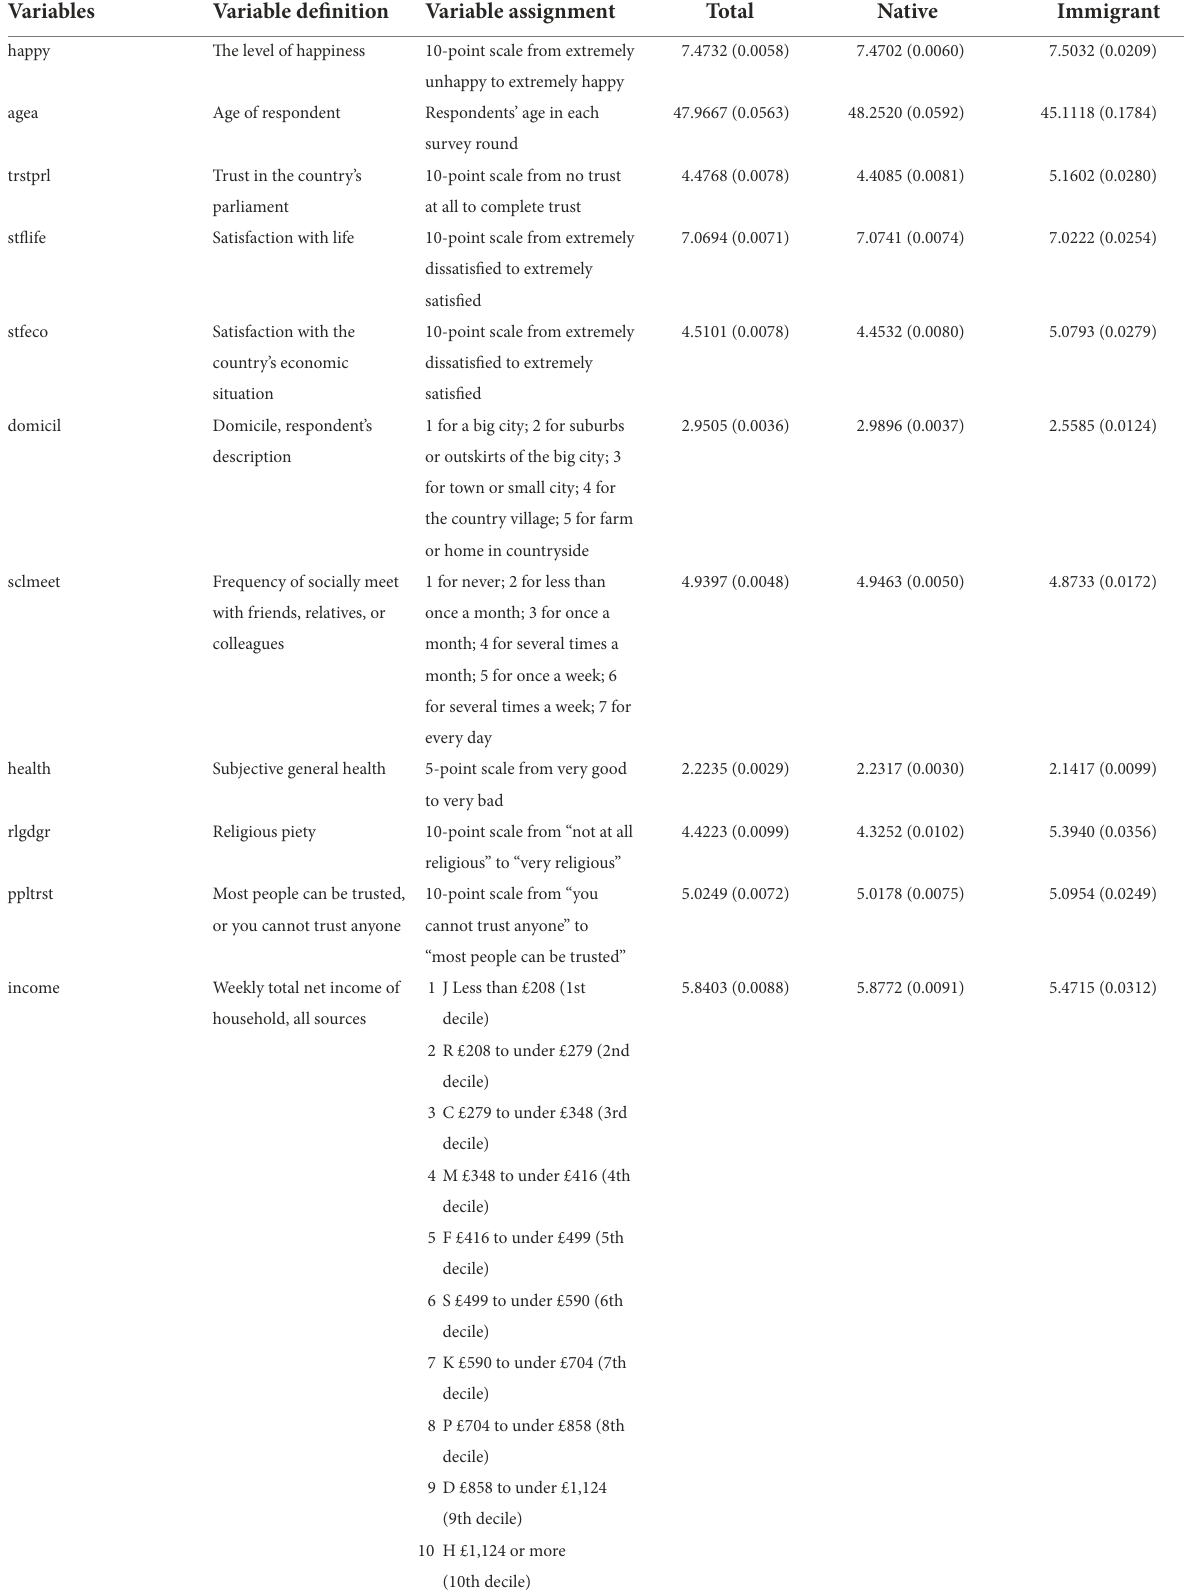
TABLE 1 Variable definition and descriptive